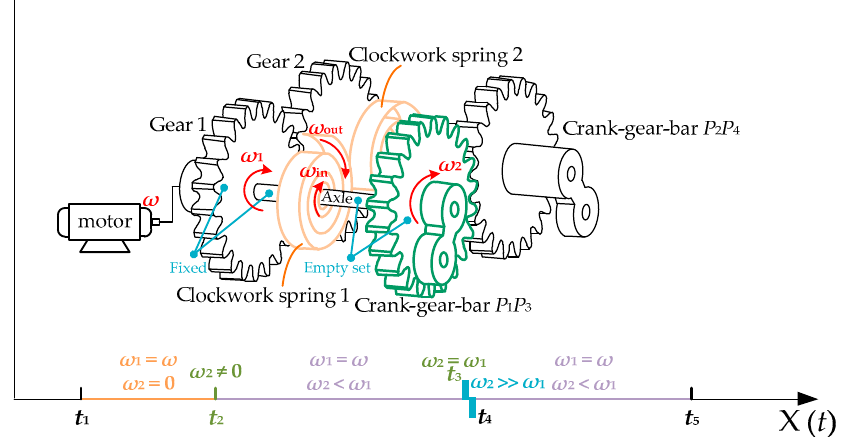
Figure 9. Energy-stored type actuator. The clockwork spring is introduced between the motor output shaft and the crank-gear-bar as an auxiliary energy storage element.